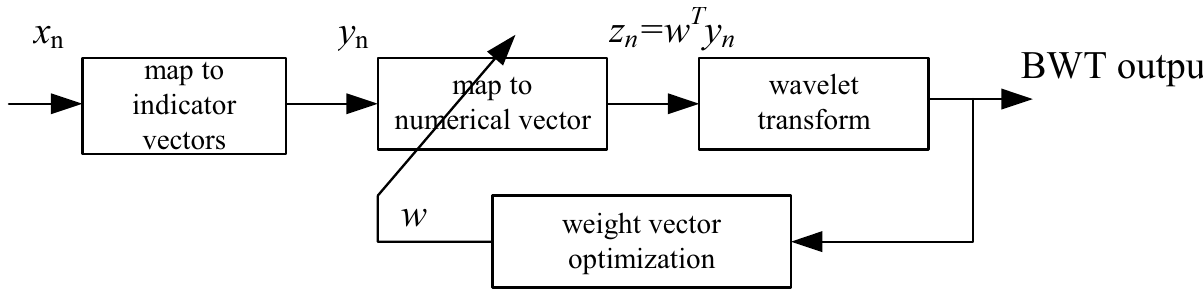
Figure 3 BWT analysis of symbolic sequence based on adaptive symbol-to-number mapping. The optimisation can maximise the BWT energy output and adjust the weight vector. Thus, the whole BWT calculation is adaptive and nonlinear.